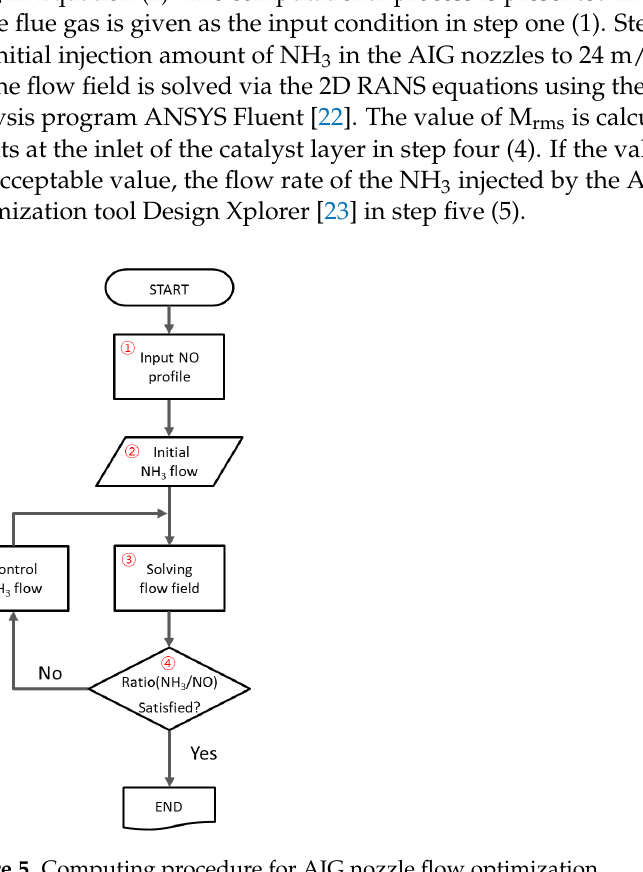
Figure 6. Computational meshes around the ammonia injection nozzles and the turning-diffusing parts.